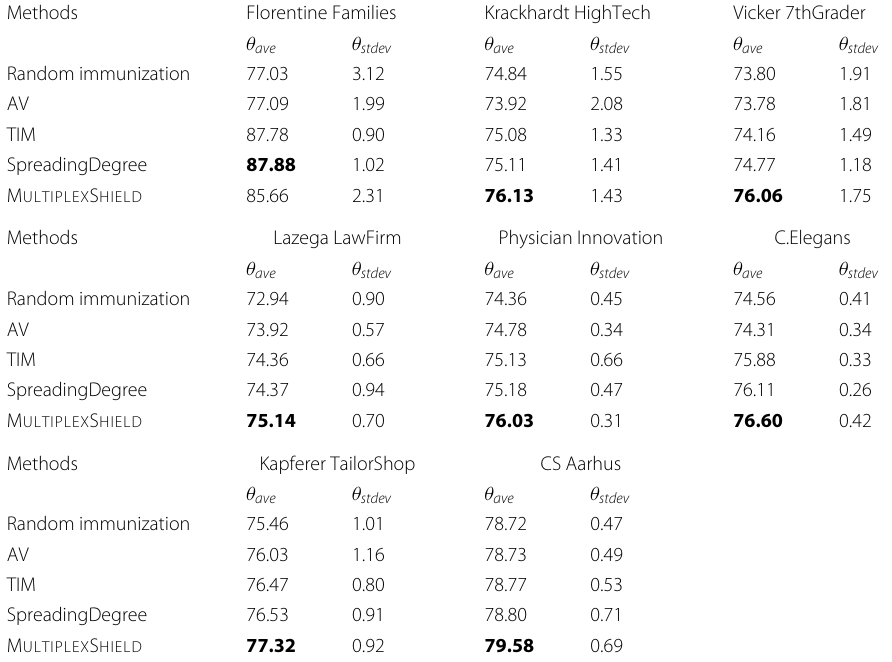
Table 6 Layer-based protection scheme, targeted high-degree nodes attack scenario